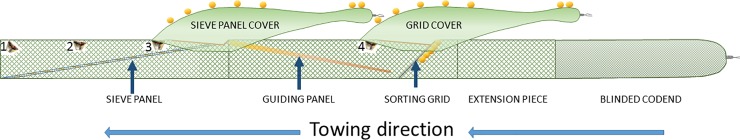
Illustration of the experimental gear design used during the trials (side view).The numbers 1, 2, 3 and 4 indicate the positions of underwater cameras during observations.